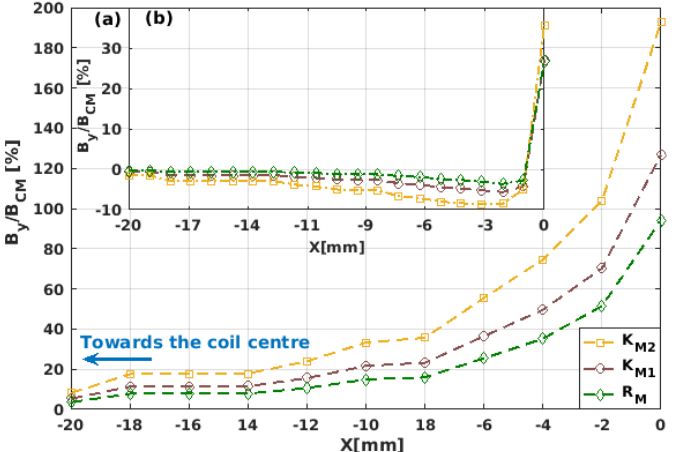
Figure 5. Magnetic field component B y along the middle axisymmetric line ( x -axis) of the 2G-HTS coil calculated within the Kim-based approaches K M 1 , K M 2 , and R M (Table 1) as a percentage function relative to the field predicted by the isotropic C M model. The measured field is presented from the innermost turn of the coil at 0 mm (see Figure 3) towards the coil centre at the self-field condition ω t = 2 π , when the applied current has an amplitude of ( a ) I a = 0.5 I c 0 (i.e., with the central turns of the HTS coil partly magnetised (see Figure 1)), and ( b ) I a = I c 0 (inset), that is, with the HTS coil fully saturated by the transport current and no magnetisation